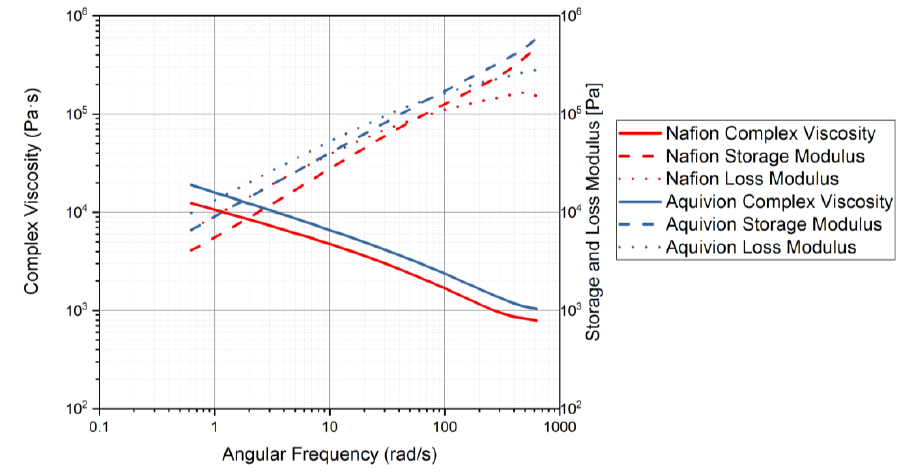
Figure 14. Rheology tests with an applied angular frequency to measure the complex viscosity and storage and loss modulus. Precursor Nafion was tested at 200 °C and precursor Aquivion was tested at 240 °C.